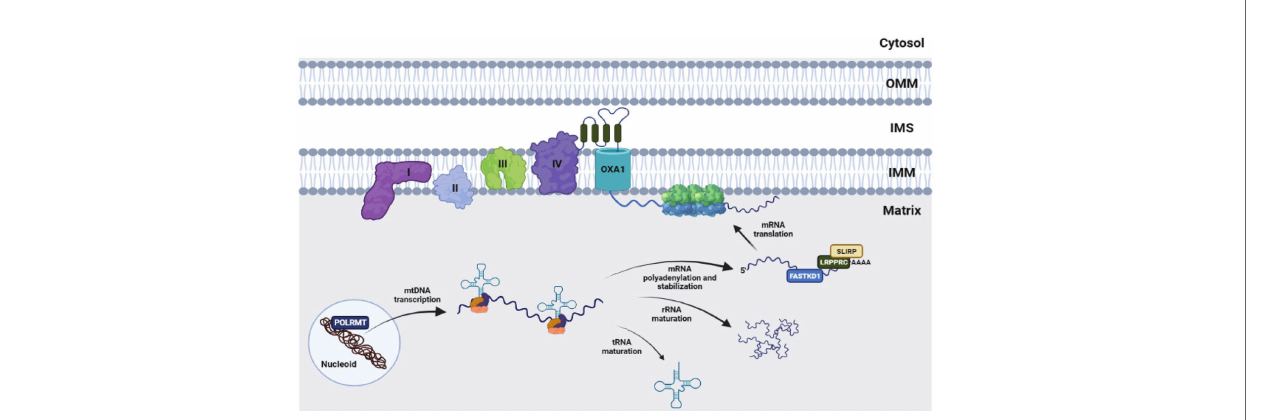
FIGURE 1 | The mtDNA is organized in structures called “ nucleoids ” , in which both core and peripheral proteins contribute to organization, stability and communication of the mtDNA with additional factors. Among the nucleoid components, POLRMT plays a key role, being responsible for the transcription process. Subsequently, the original polycistronic transcript is subject to extensive maturation, yielding mitochondrial tRNAs, rRNAs and mRNAs. The latter encode 13 polypeptides, all members of the respiratory chain, can be stabilized and regulated by RNA-binding proteins such as LRPPRC, SLIRP FASTKD1, and fi nally translated by inner